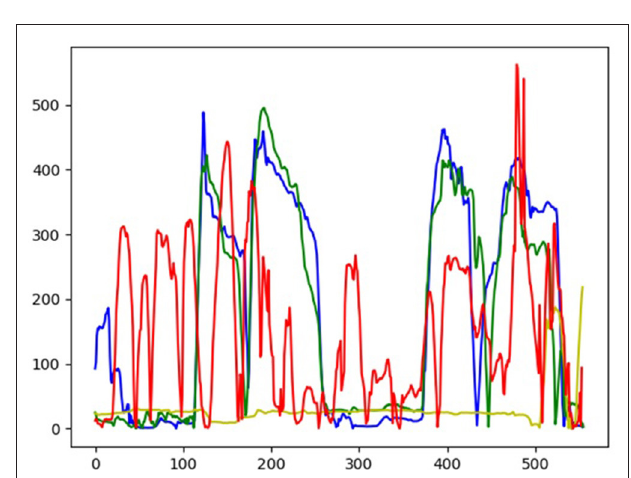
FIGURE 3 | User output from motor Assessment Test 1 (Balance & Walking) related with the distance between user’s ankles [see (1)]. The blue color indicates the motion of the expert user, while the lines with the other colors belong to three different users (green: good performance, red: wrong execution, yellow: no